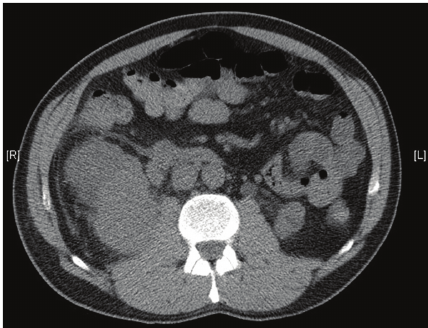
Figure 3: Histopathology of primary plasmacytoma of the